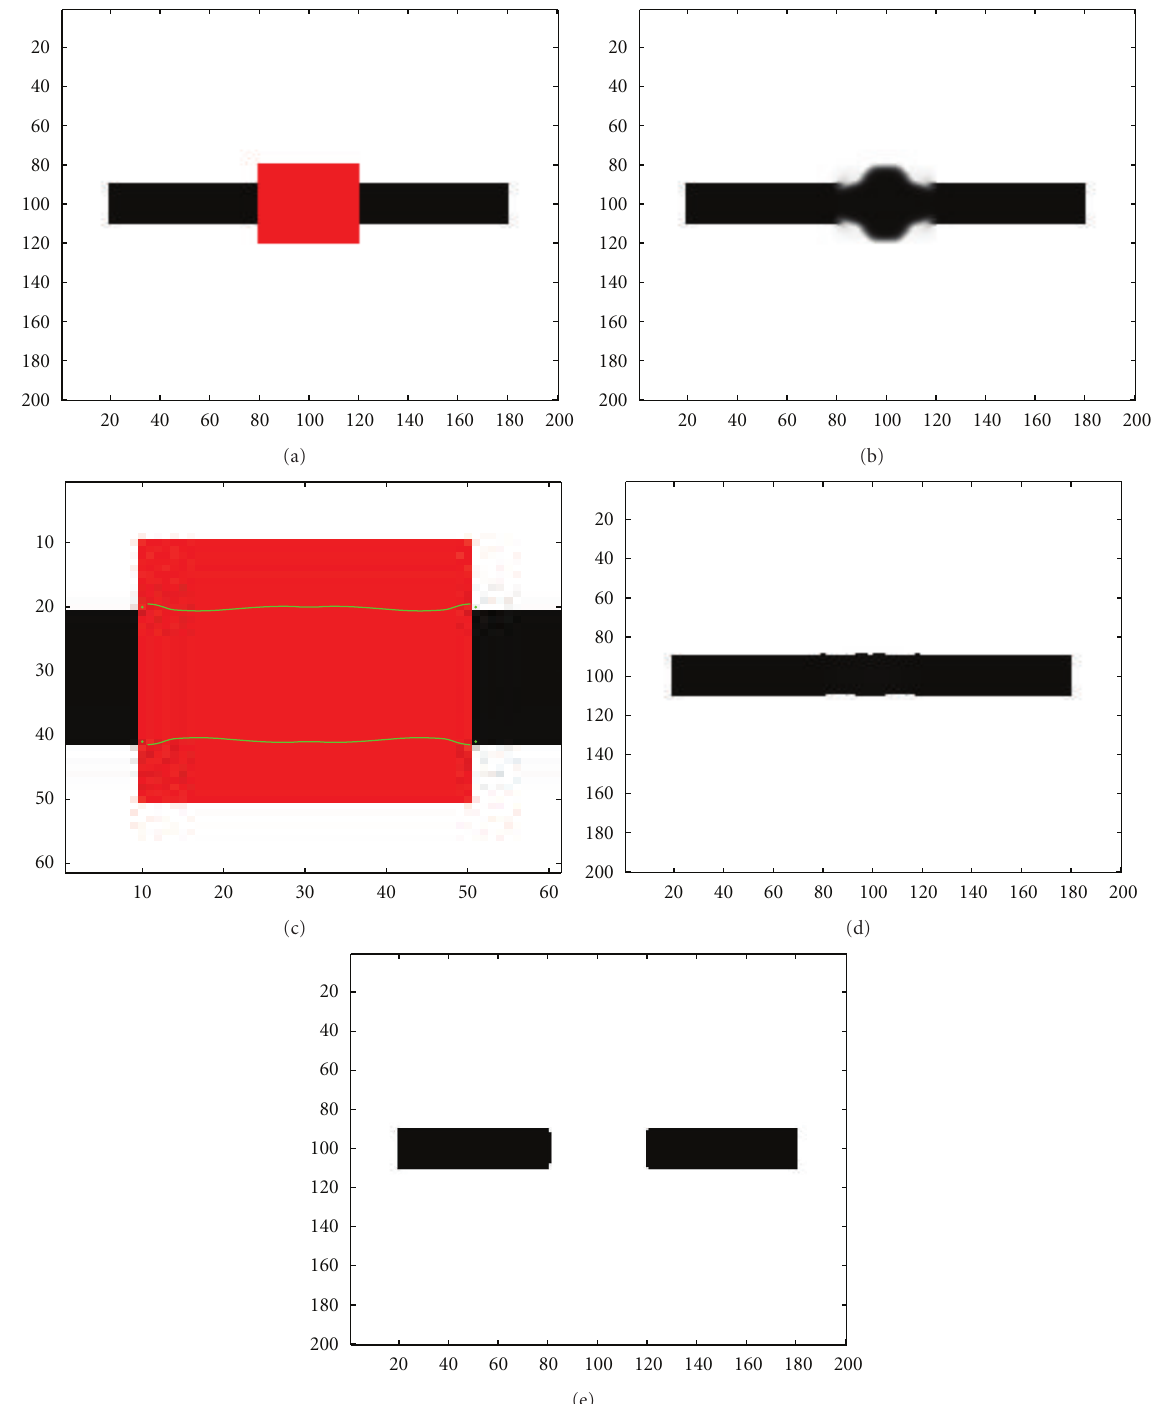
Figure 9: (a) Occluded image (black rectangle) by a red rectangle; (b) Inpainted image using the standard topological gradient; (c) Minimal path between the keypoints represented on the topological gradient; (d) Inpainted image using the hybrid scheme (fast marching algorithm for closing the contours identified by the topological gradient); (e) Inpainted image using a TV-based